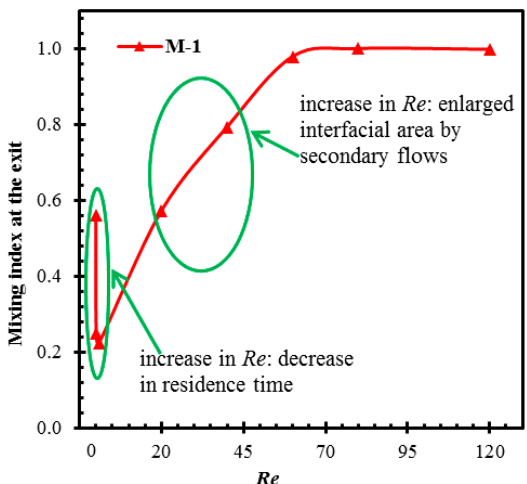
Figure 11. Variation of the mixing index at the exit with Reynolds number in a curved micromixer [40].